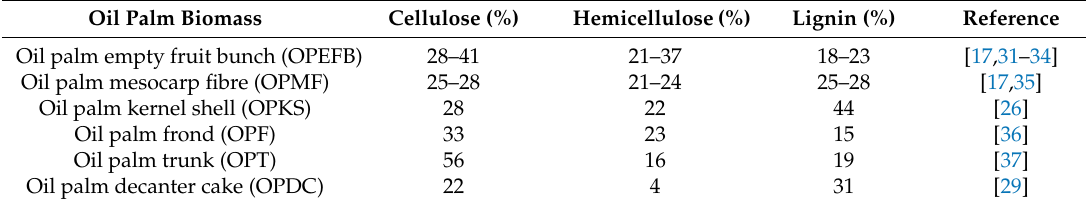
Table 1. Chemical composition of various raw oil palm